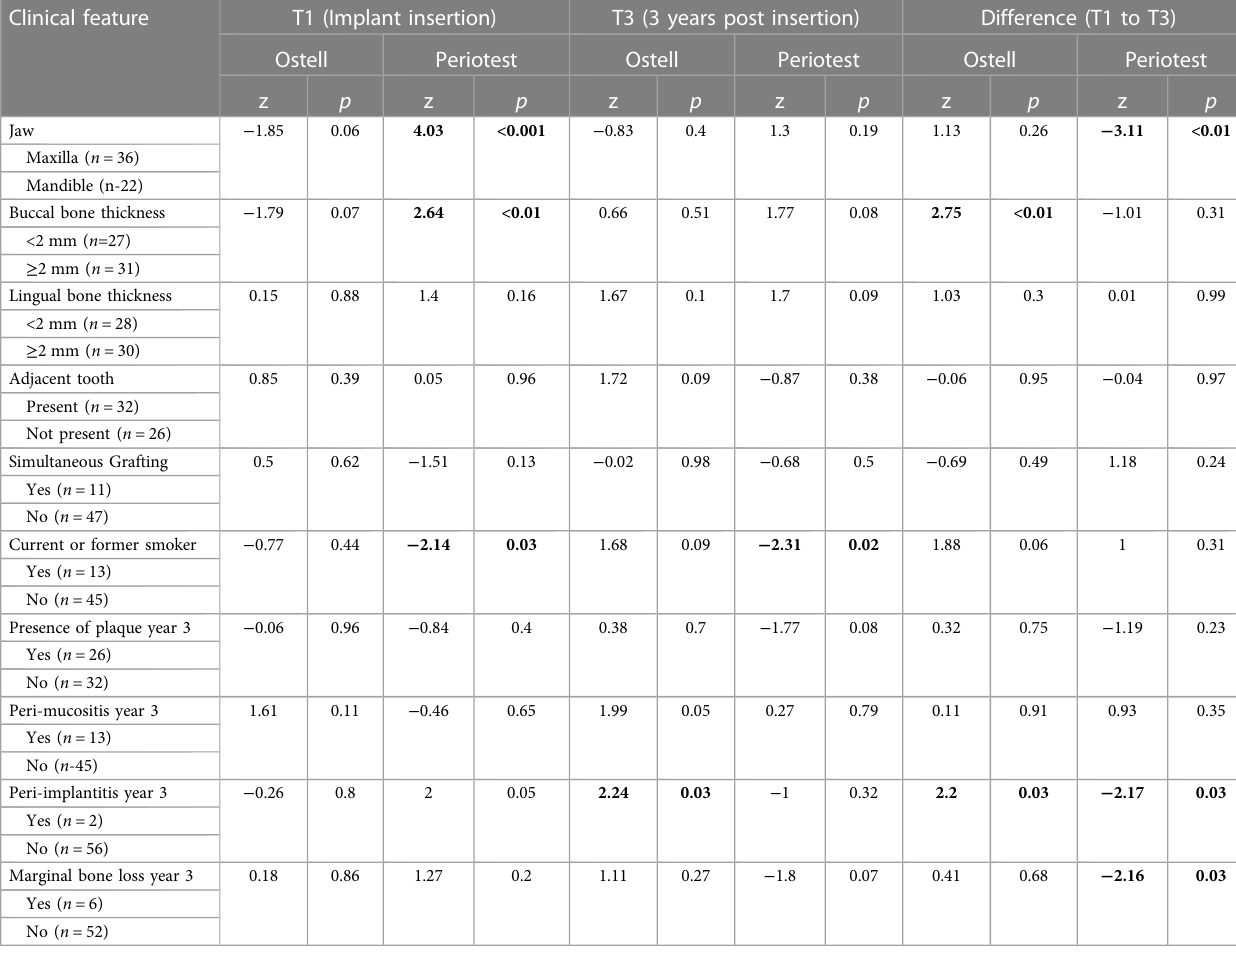
TABLE 3 Wilcoxon rank-sum for osstell ® and periotest ® measurements by clinical feature at T1, T3, and difference T1 to T3, n =58. Clinical